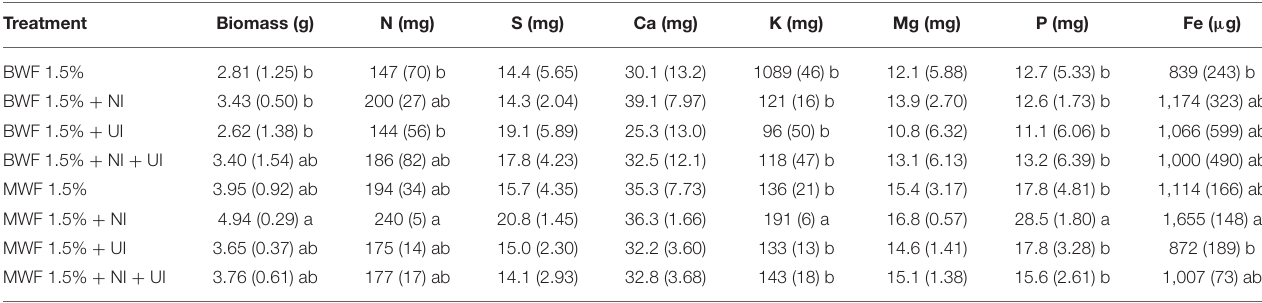
TABLE 2 | Cumulated Italian ryegrass shoot dry weight and nutrient uptake in pots amended with 1.5% (w/w) buffalo worm frass, BWF or mealworm frass, MWF (mean ± standard deviation for n = 5).